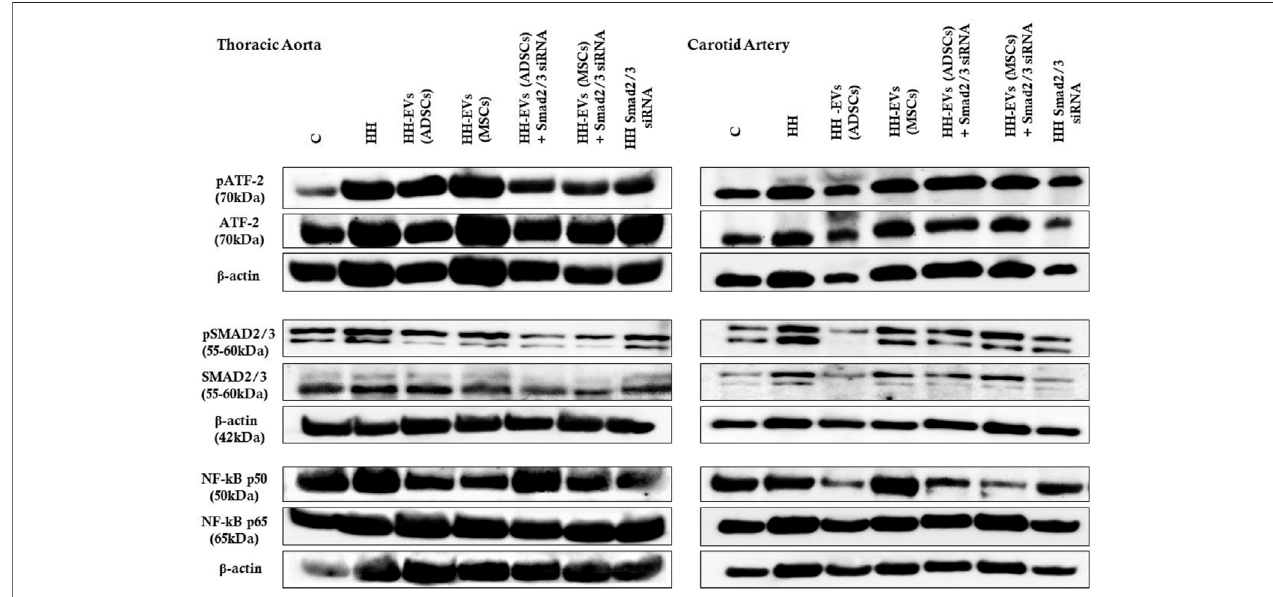
FIGURE10| RepresentativeWesternblottingimagesoftheexpressionlevelsofpATF-2,ATF-2,pSMAD2/3,SMAD2/3,NF-kBp50,NF-kBp65,and β -actininboth thoracic aorta (left) and carotid artery (right) explanted from all seven experimental animal groups.